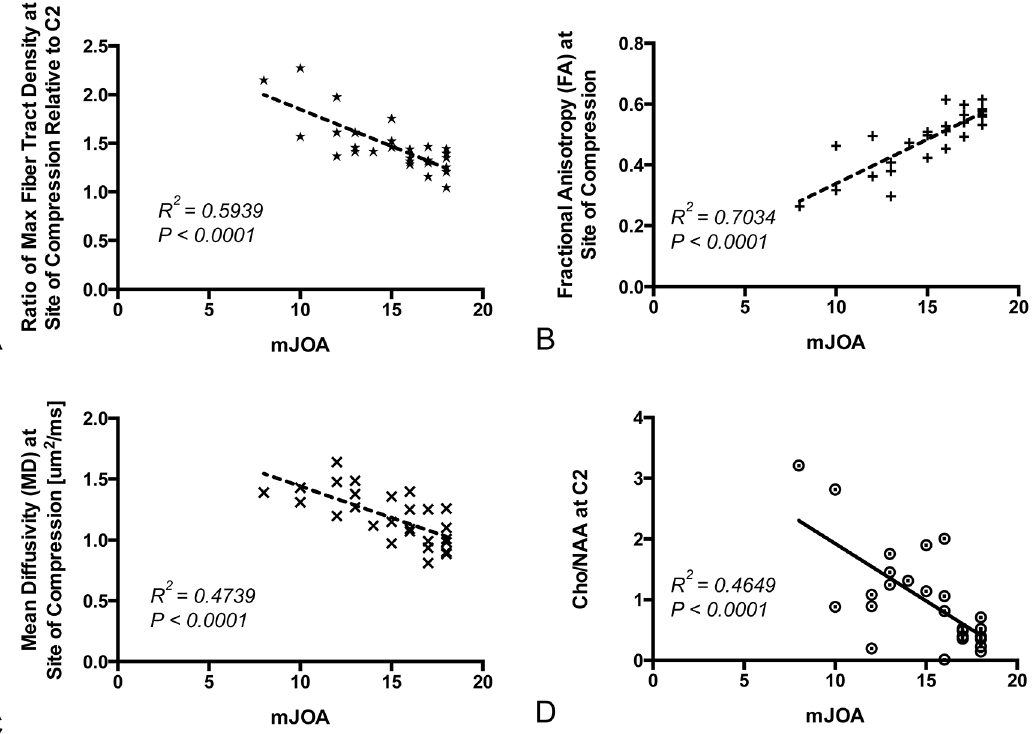
Fig 2. Correlation Between Individual MR Measurements and mJOA. A) Ratio of maximum fiber tract density at the site of compression to fiber tract density at C2 versus mJOA ( R 2 = 0 . 5939 , P < 0 . 0001 ). B) Fractional anisotropy (FA) at the site of greatest stenosis versus mJOA ( R 2 = 0 . 7034 , P < 0 . 0001 ). C) Mean diffusivity (MD) at the site of greatest stenosis versus mJOA ( R 2 = 0 . 4739 , P < 0 . 0001 ). D) Cho/NAA ratio measured at C2 versus mJOA score ( R 2 = 0 . 4649 , P < 0 . 0001)